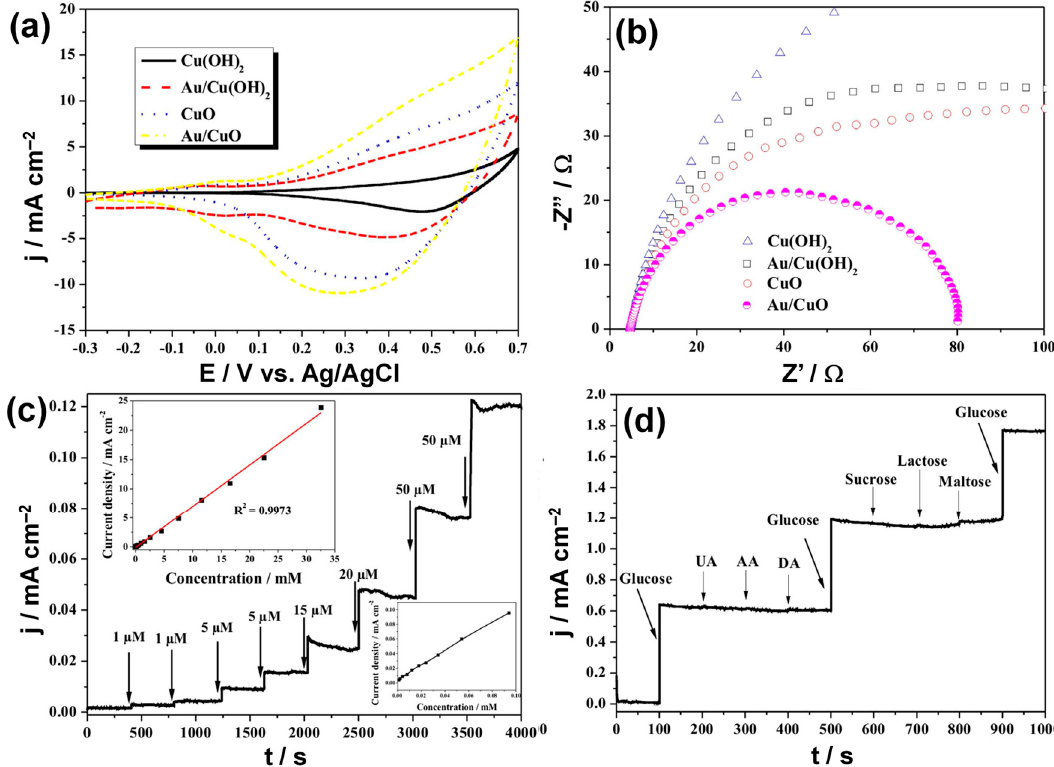
Figure 5. ( a ) Cyclic voltammograms of the Cu(OH) 2 , Au/Cu(OH) 2 , CuO and Au/CuO electrode materials in 1.0 M NaOH with a scan rate of 50 mV ∙ s − 1 ; ( b ) EIS: Nyquist plots of Cu(OH) 2 , Au/Cu(OH) 2 , CuO, and Au/CuO samples collected at open circuit potential; ( c ) Amperometric responses of the Au/CuO electrode with successive addition of glucose at 0.35 V vs. Ag|AgCl|KCl sat , the top ‐ left inset is the calibration curve at a high glucose concentration, and the bottom ‐ right inset is the calibration curve at a low glucose concentration; ( d ) Anti ‐ interference property of the Au/CuO electrode with initial addition of 1.0 mM glucose and 0.05 mM of UA, AA, and DA, and then again 1.0 mM glucose, followed by addition of 0.02 mM sucrose, lactose, and maltose, and final addition of 1.0 mM glucose at 0.35 V vs. Ag|AgCl|KCl sat . Reprinted and adapted with permission from Reference [92]. Copyright Macmillan Publishers Limited, 2016.